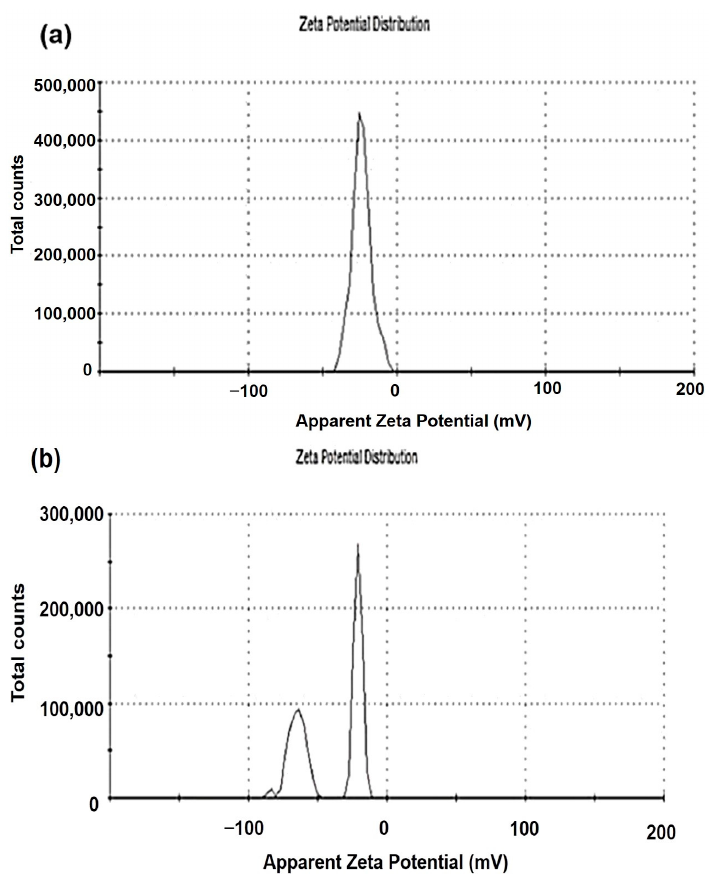
Figure 5. Studies of the ( a ) ACC ( − 23.7 mV) and ( b ) EC-R@ACC solar light spectrum photocatalyst ( − 40.1 mV) by Zeta potential pathway.